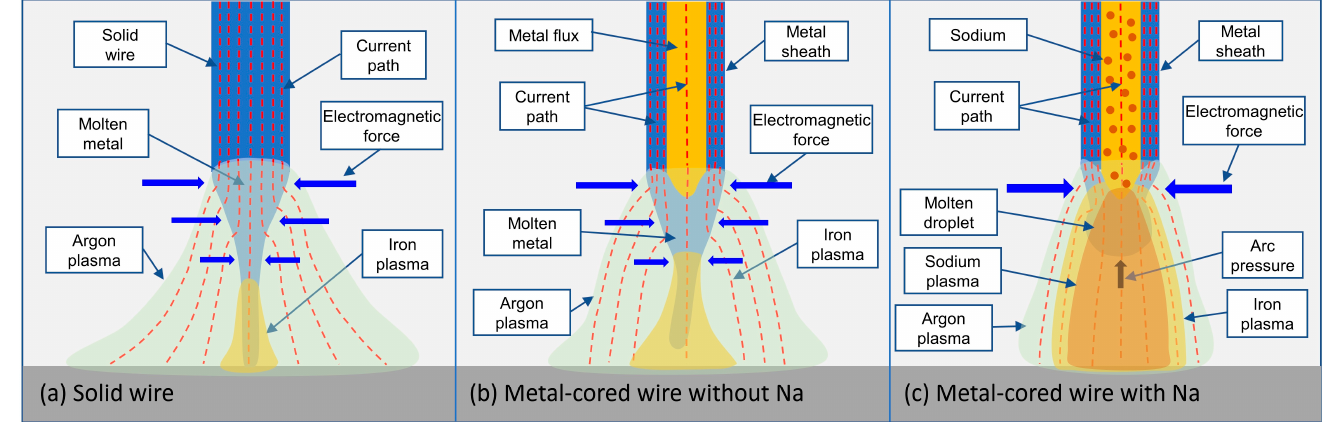
Figure 8. Mechanism of metal transfer ( a – c ) at a high welding current of 320 A.